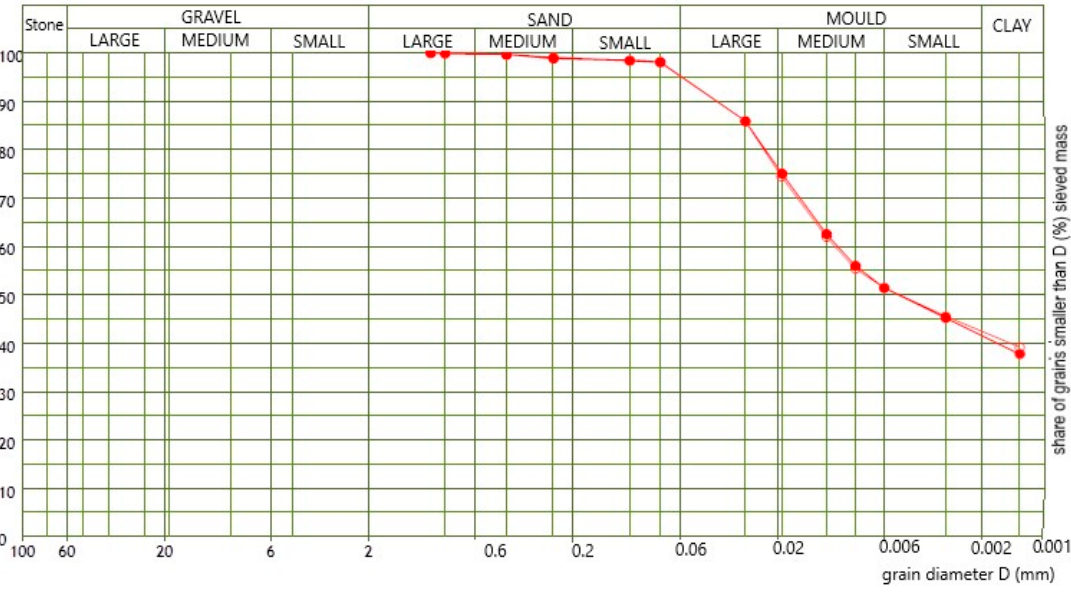
Figure 2. Particle-size distribution of two raw materials. Table 4. Particle-size distribution of two raw materials.